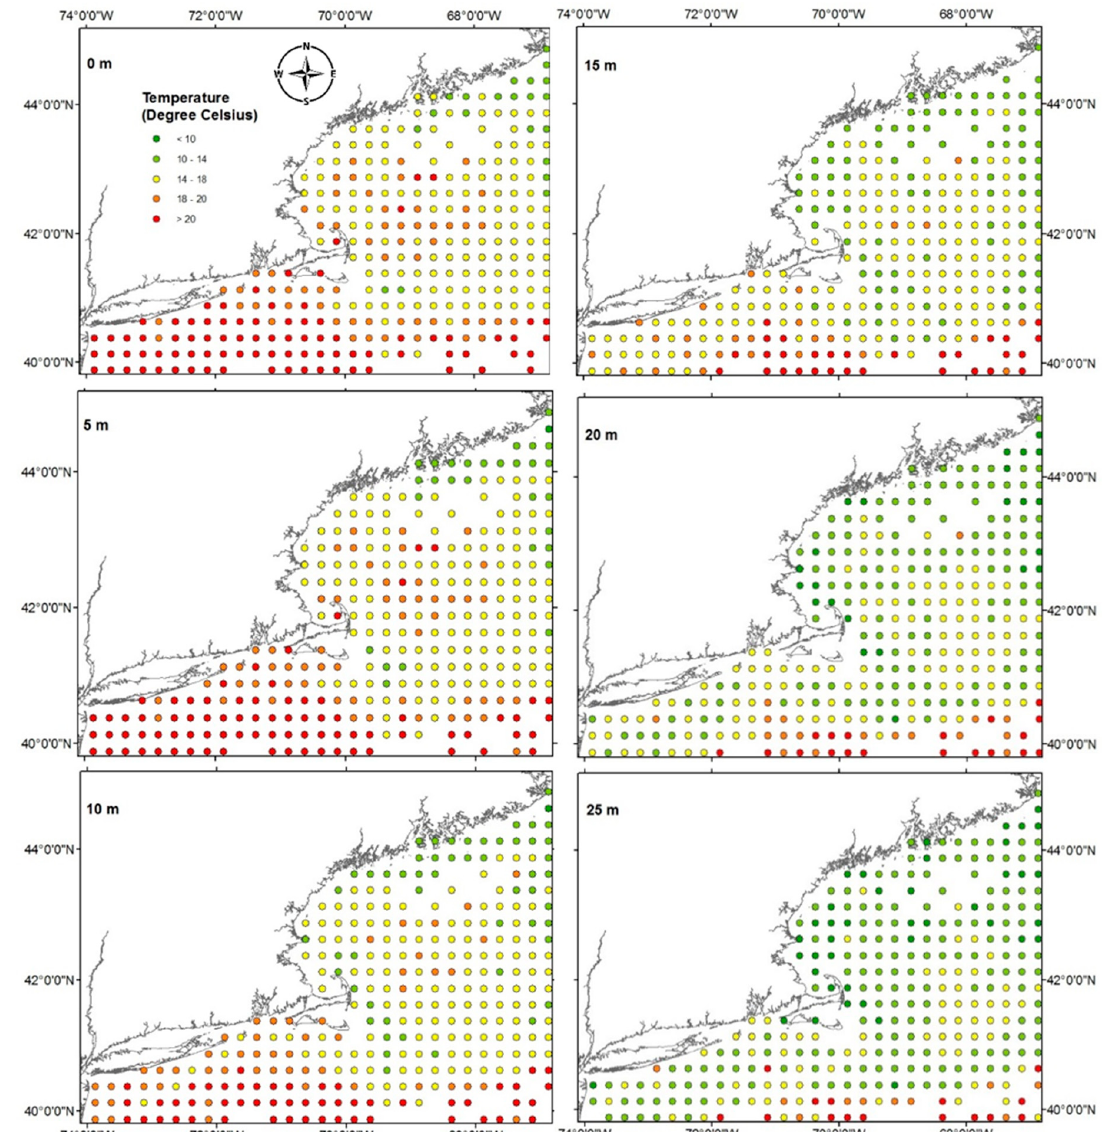
Figure 8. Depth distribution of temperatures shown as averaged means of the years 2005 to 2012 in summer.